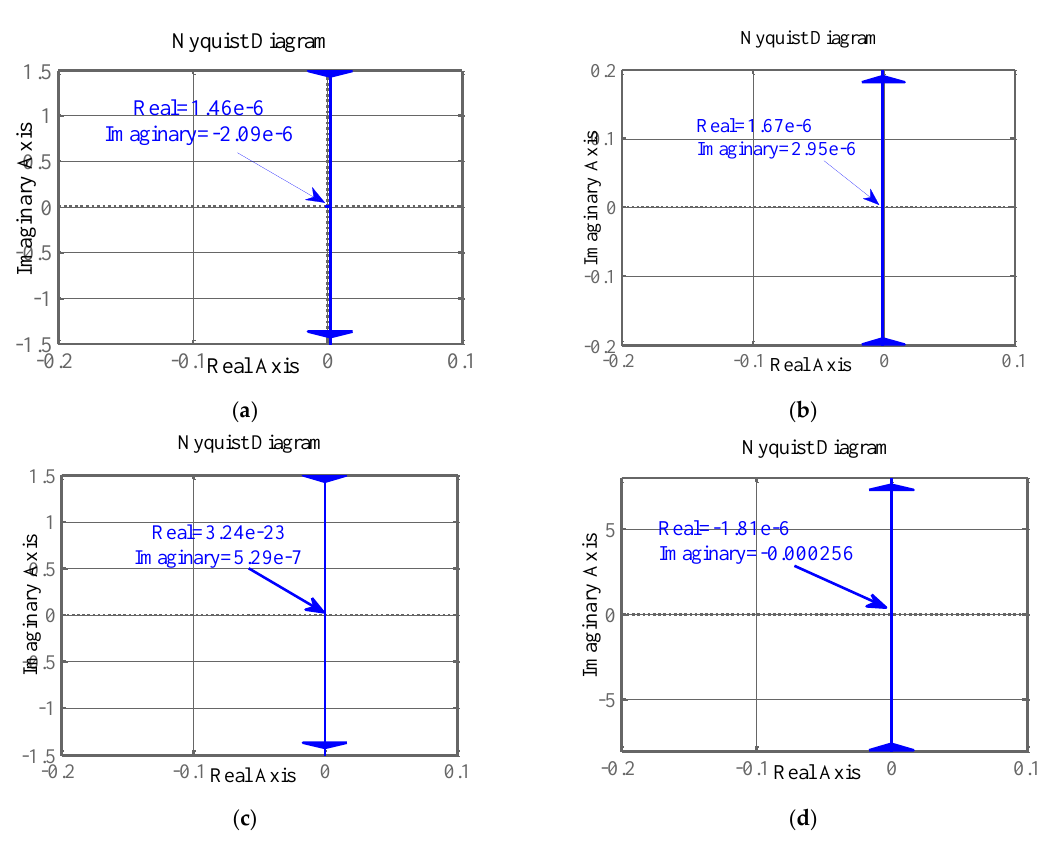
Figure 4. The Nyquist diagram of ∆ i q for constant values of: ( a ) ∆ P m ; ( b ) ∆ P ; ( c ) ∆ Q ; ( d ) ∆ v gd Figure 4 . The Nyquist diagram of Δ i q for constant values of: ( a ) Δ P m ; ( b ) Δ P ; ( c ) Δ Q ; ( d ) Δ v gd .